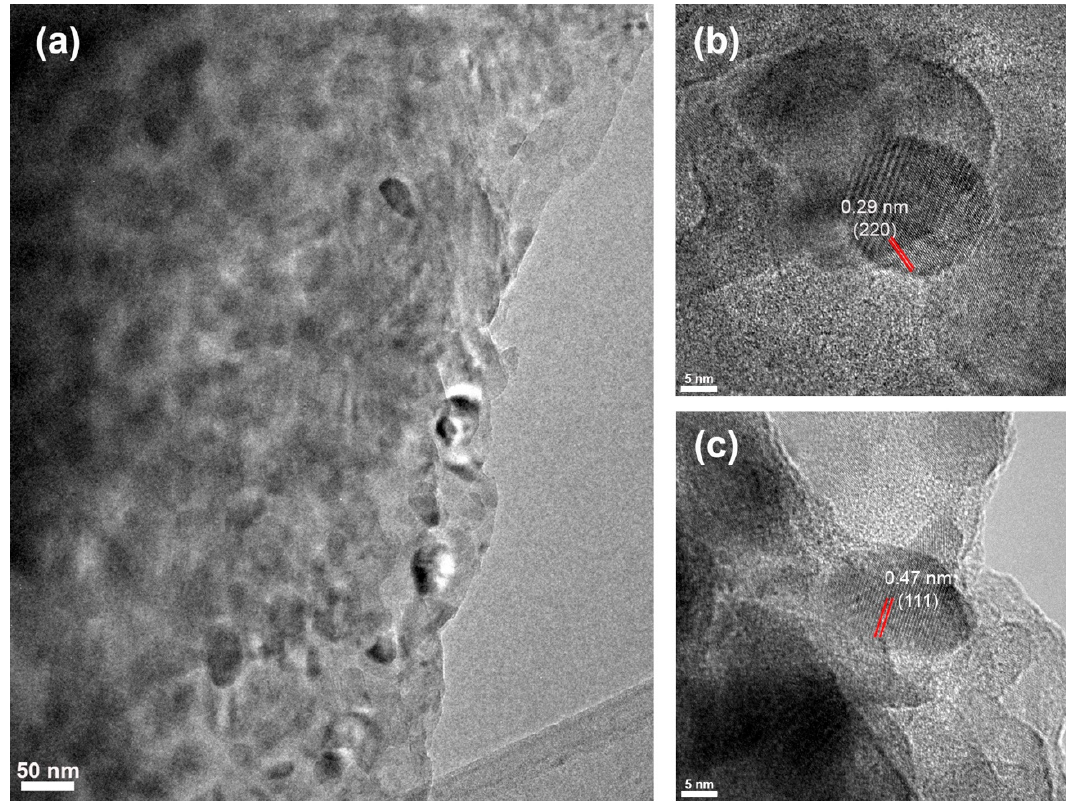
Figure 7. ( a ) TEM images of zone D; ( b , c ) HRTEM images of gahnite nanocrystals with the corre- sponding interplanar spacings. Red lines highlight the interplanar distance.